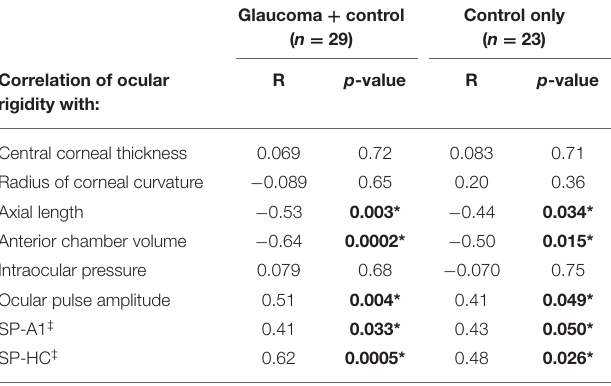
TABLE 2 | Correlation of ocular rigidity with morphological characteristics and stiffness parameters. Glaucoma + control ( n =